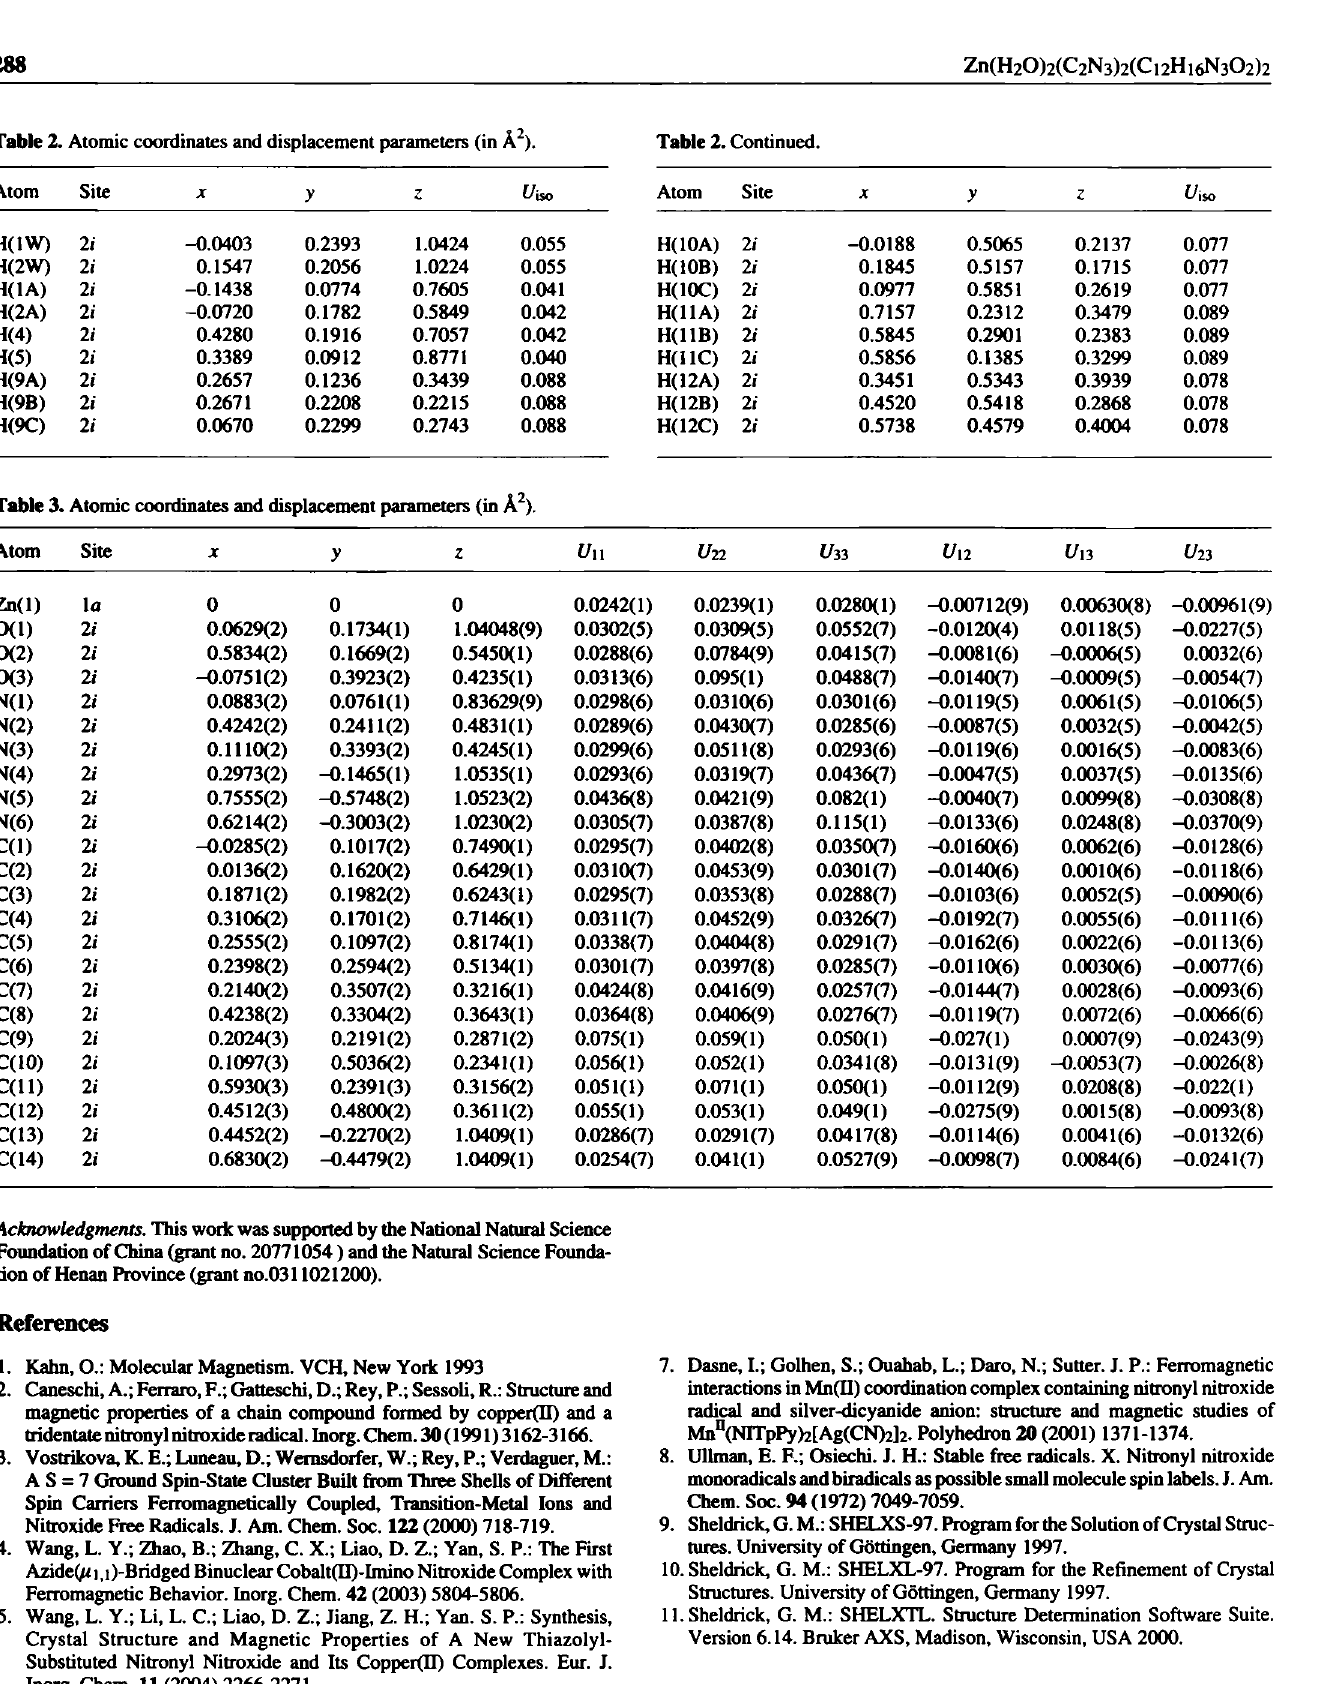
Table 2. Atomic coordinates and displacement parameters (in Â 2 ). Table 2. Continued.